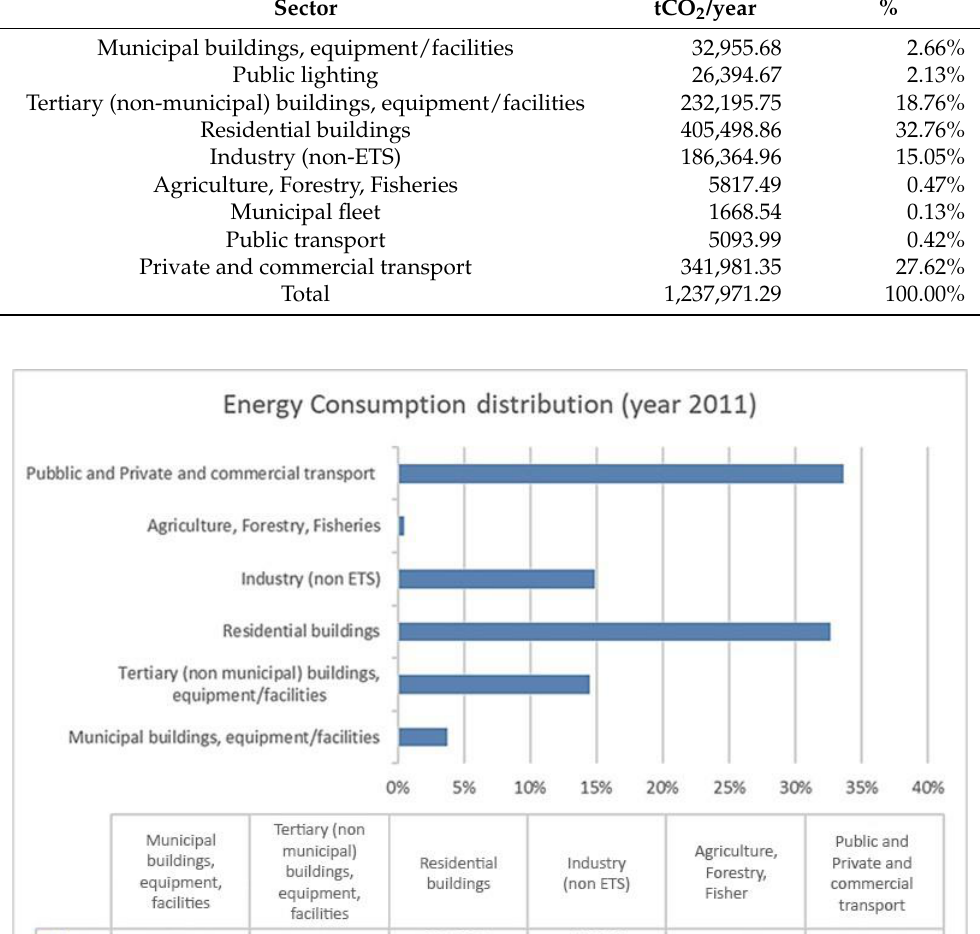
Table 6. Energy consumption distribution (MWh/year).